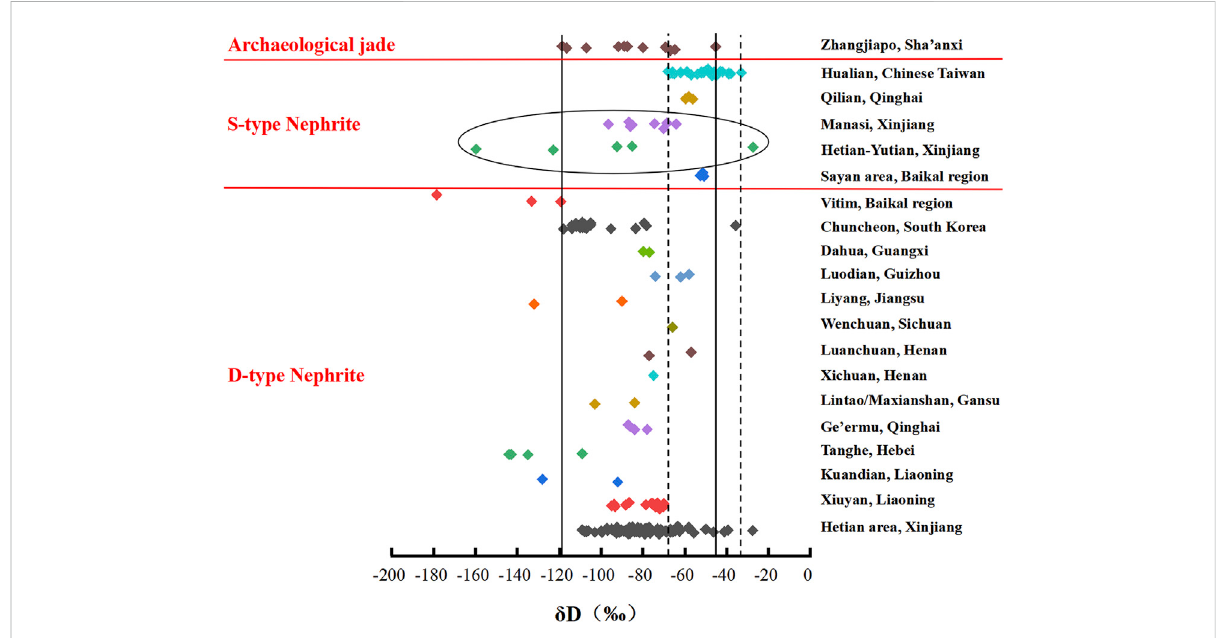
FIGURE 7 Comparative analysis of hydrogen isotopes between modern nephrite deposits and excavated nephrite jadewares (The range of black lines represents the hydrogen isotope values of excavated jadewares, and the ellipse area represents the hydrogen isotope values of S-type nephrite in Xinjiang, as well as the dashed line represents the oxygen isotope values of S-type nephrite in Hualian, Qilian and Sayan